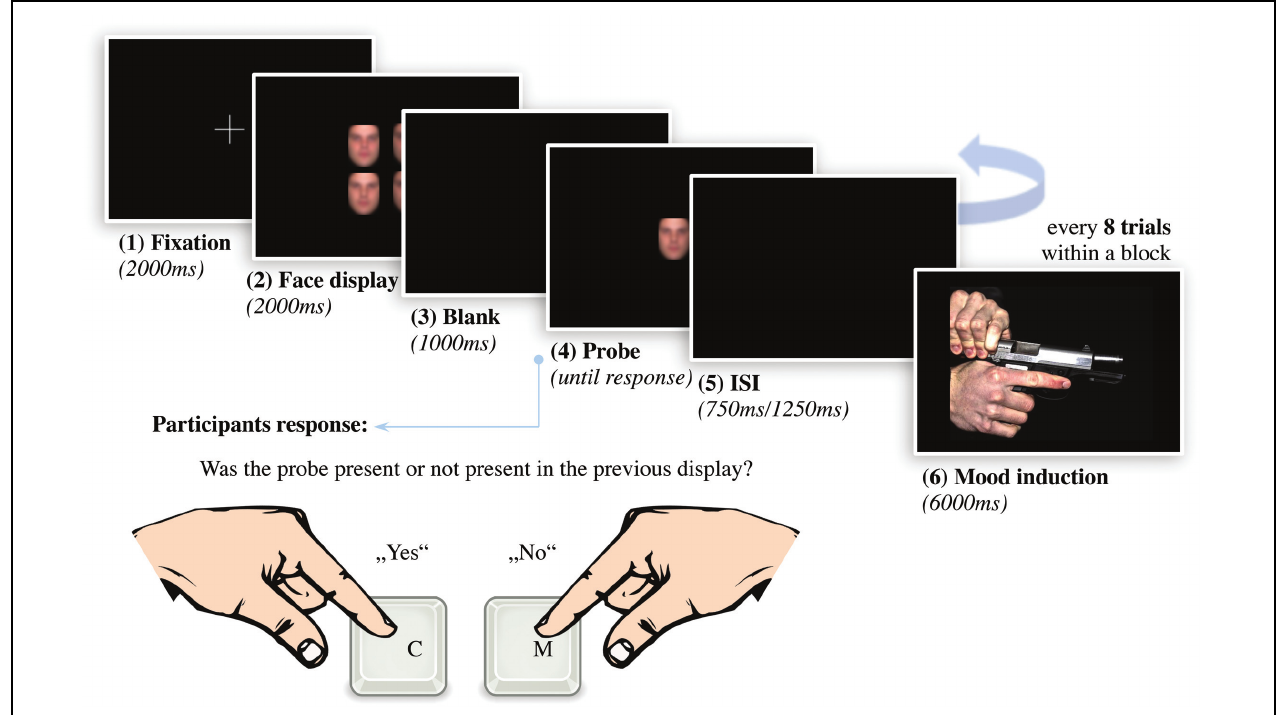
FIGURE 2 | Structure of the experimental task to register VWM for emotionally expressive faces with experimental mood induction. After presenting a fixation cross for 2000 ms, we showed a 2 × 2 array of four faces displaying the same emotional expression for 2000 ms. After a retention interval of 1000 ms, a single test face was presented.